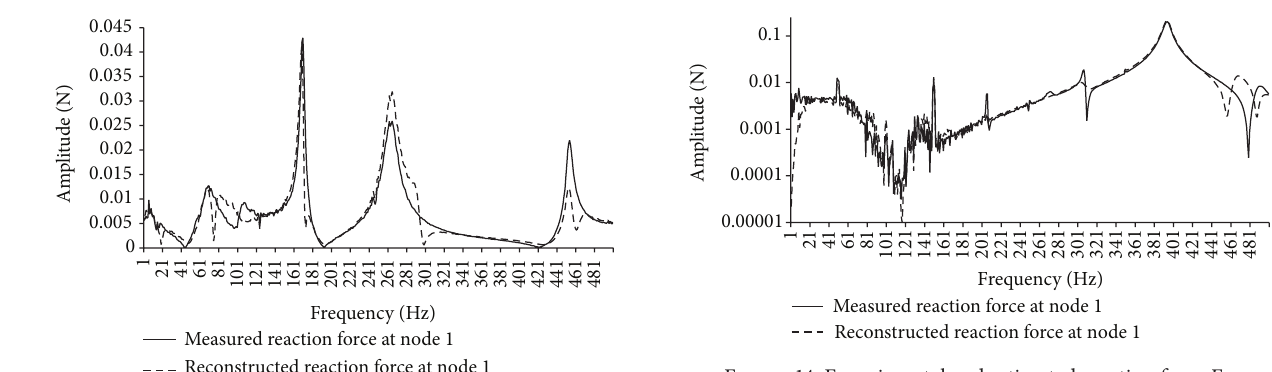
Figure 14: Experimental and estimated reaction force 𝐹 1 .